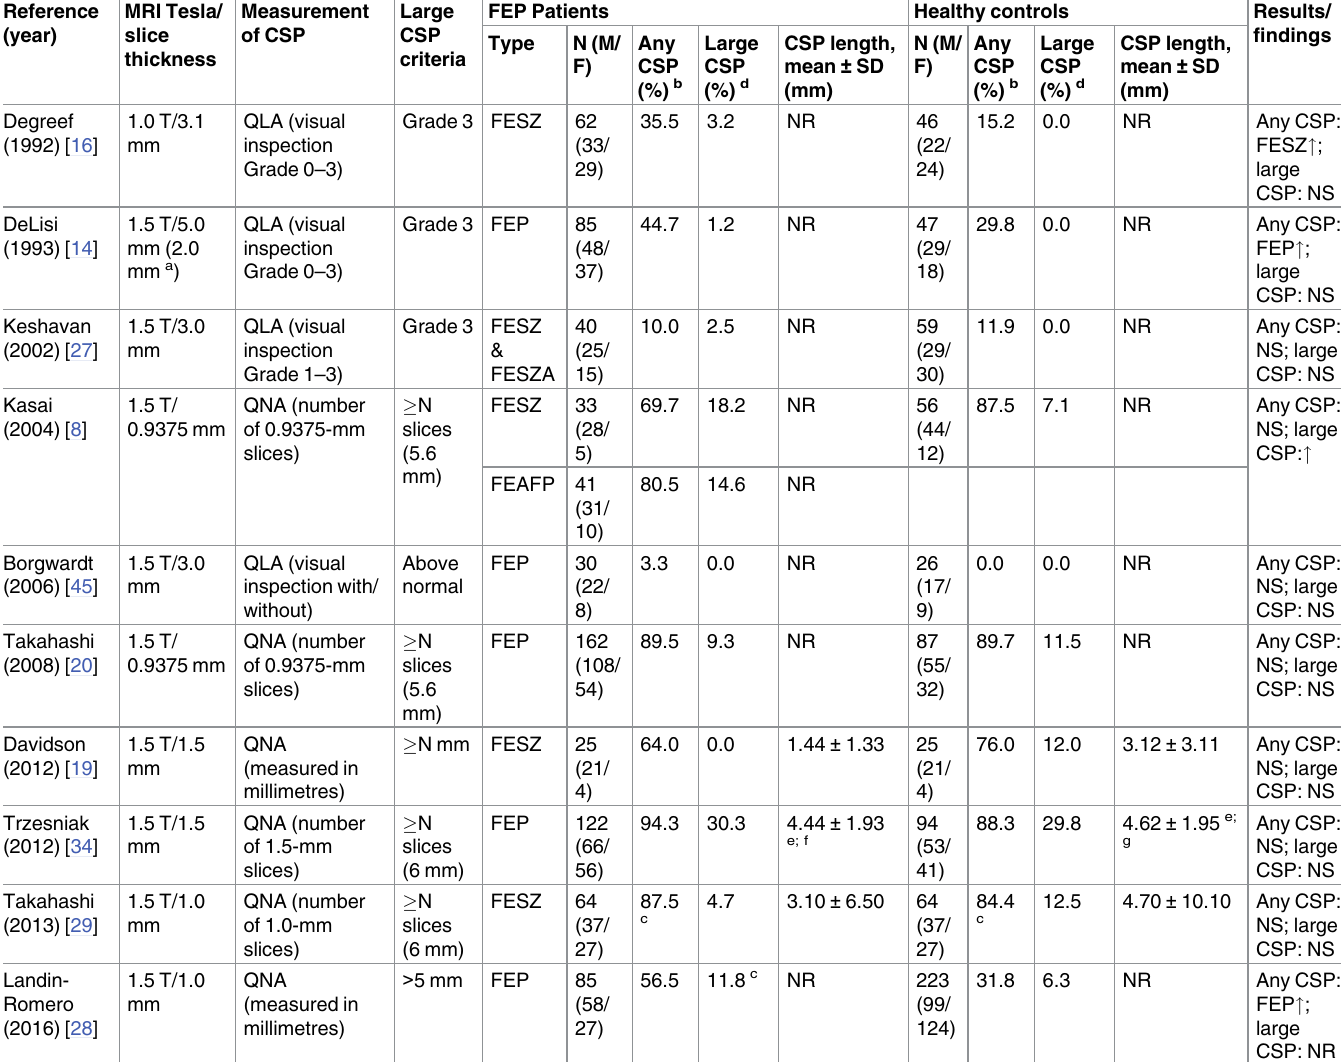
Table 2. CSP prevalence and results of the cross-sectional